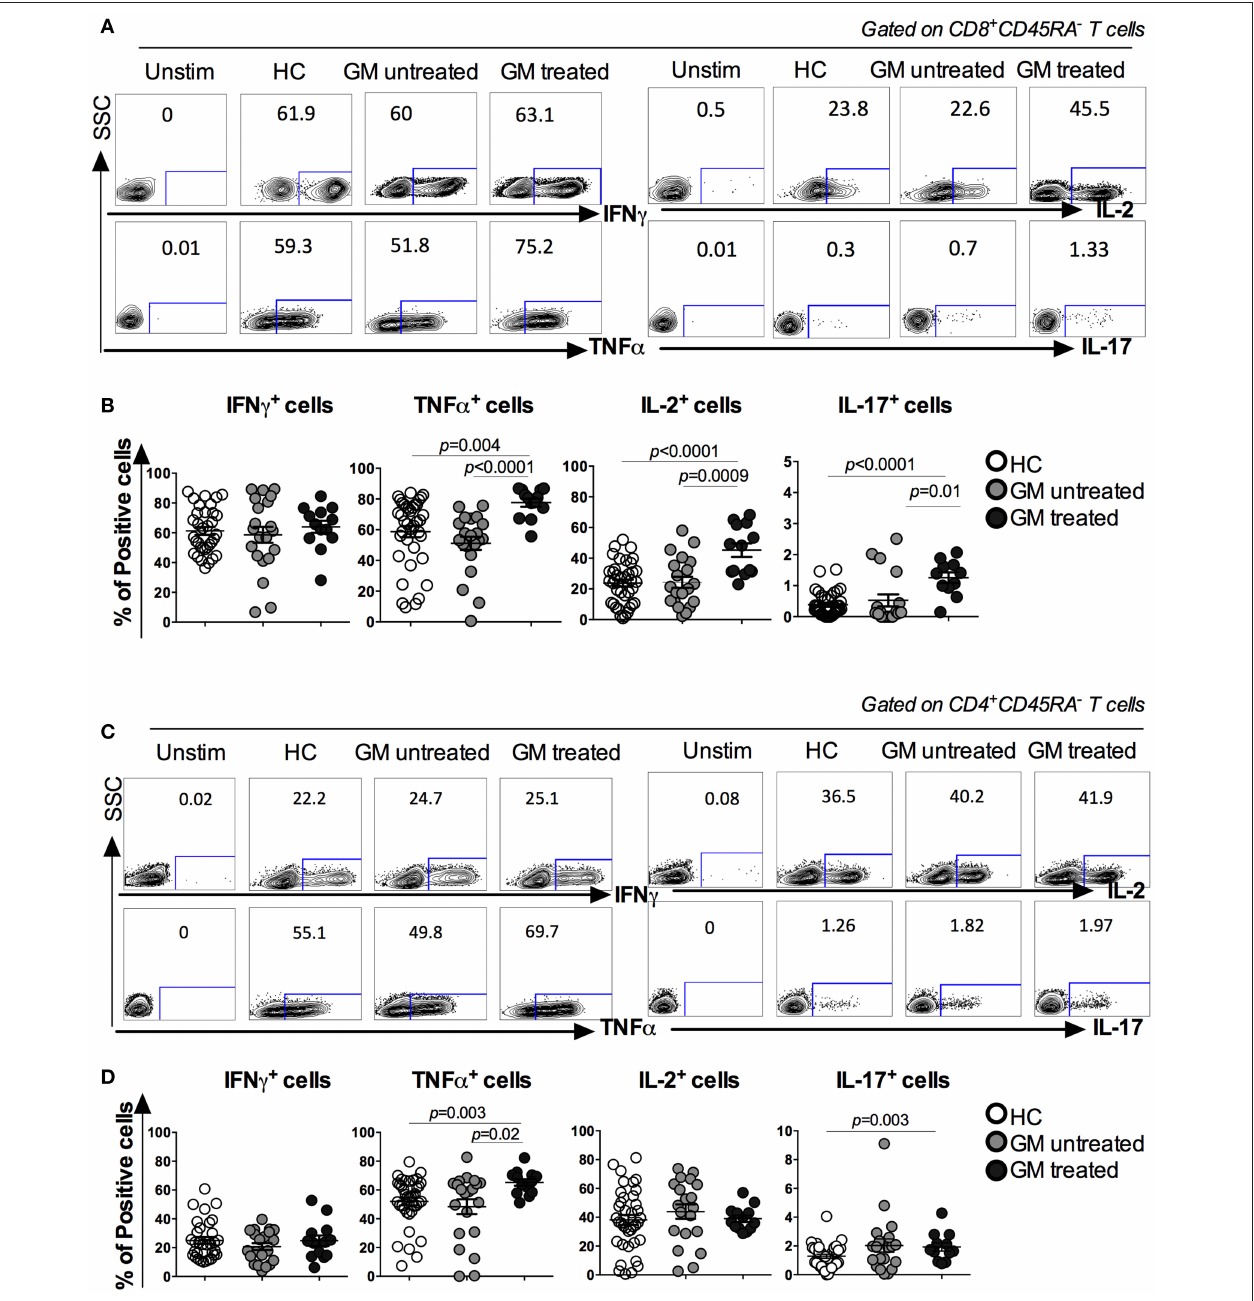
FIGURE 2 | Increased cytokine production in CD8 + CD45RA − and CD4 + CD45RA − T cells in GM treated patients. Freshly isolated PBMCs were stimulated with PMA/Iono for 6h and IFN γ , TNF α , IL-2, and IL-17 production were detected by intracellular cytokine staining. (A,C) representatives of ICS analysis of CD8 and CD4T cells from HC, GM untreated and GM treated RA patients. (B) Statistical analysis of IFN γ , TNF α , IL-2, and IL-17 secreting CD8 T M cells in GM untreated patients ( n = 21), GM treated patients ( n = 14) and control individuals ( n = 68). (D) Statistical analysis of IFN γ , TNF α , IL-2, and IL-17 secreting CD4 T M cells from GM untreated patients ( n = 21), GM treated patients ( n = 14) and control individuals ( n =